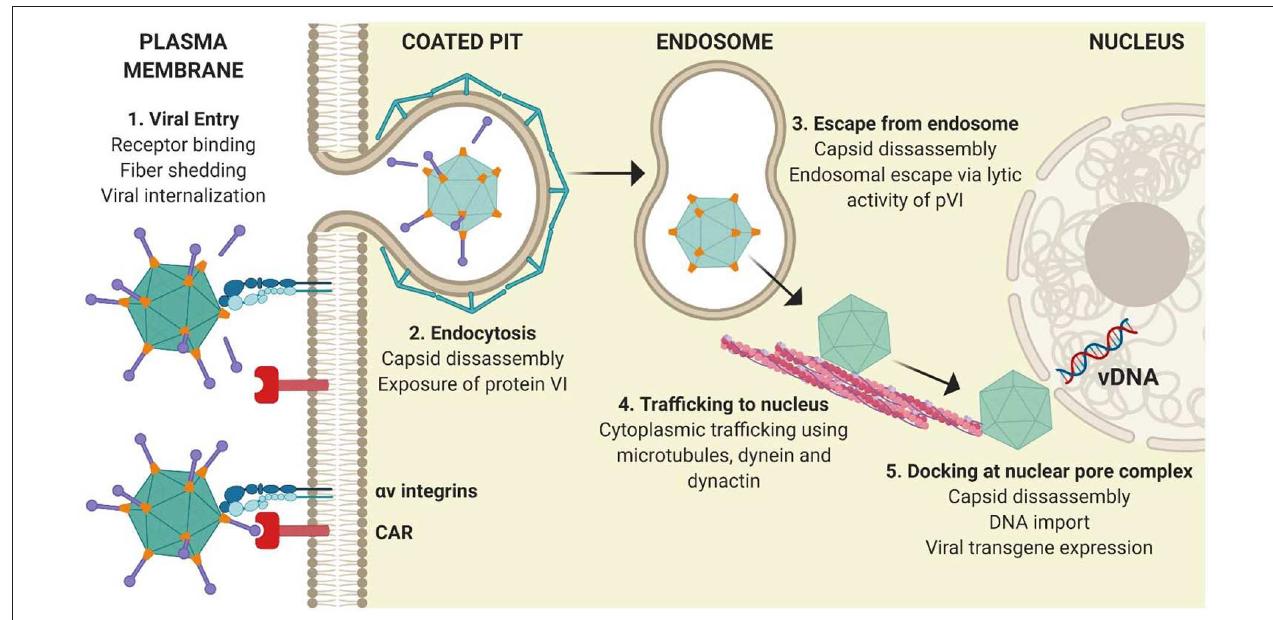
FIGURE 2 | Classical adenoviral entry pathway. (1) Attachment of the Ad5 adenoviral fiber knob mediates primary receptor interactions with CAR, followed by an interaction between the RGD motif within the penton base and cellular integrins on the surface of cells, which initiate partial capsid disassembly by fiber shedding. (2) Internalization of virions is mediated by integrins. (3) Exposure of pVI from the virion interior facilitates its lytic activity and allows endosomal escape. (4) Partially disassembled nucleocapsid cores traffic to the nucleus using the microtubule network before docking at the nuclear pore complex. (5) Viral DNA enters the nucleus and viral transgene expression is initiated. Figure is updated from Coughlan et al. (18) and was created with © BioRender -